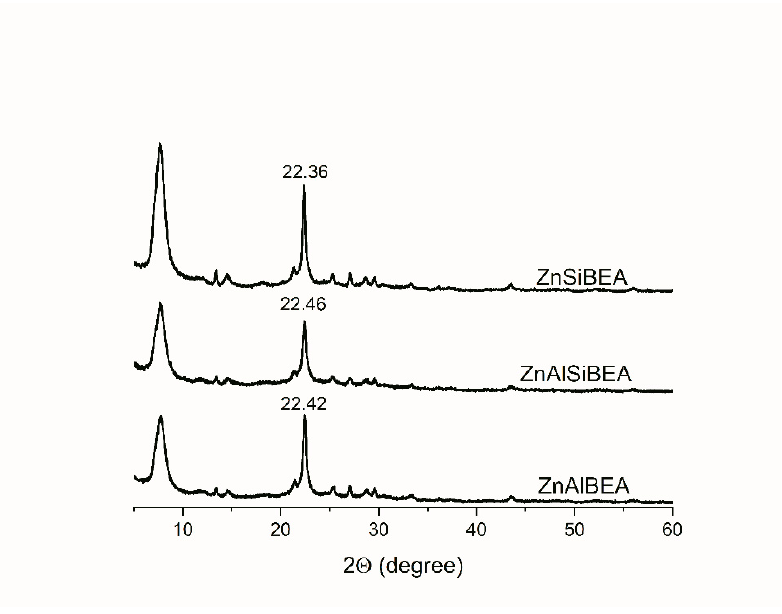
Figure 1. X-ray di ff raction pa tt erns of Zn-BEA samples after calcination at 923 K. Figure 1. X-ray diffraction patterns of Zn-BEA samples after calcination at 923 K.